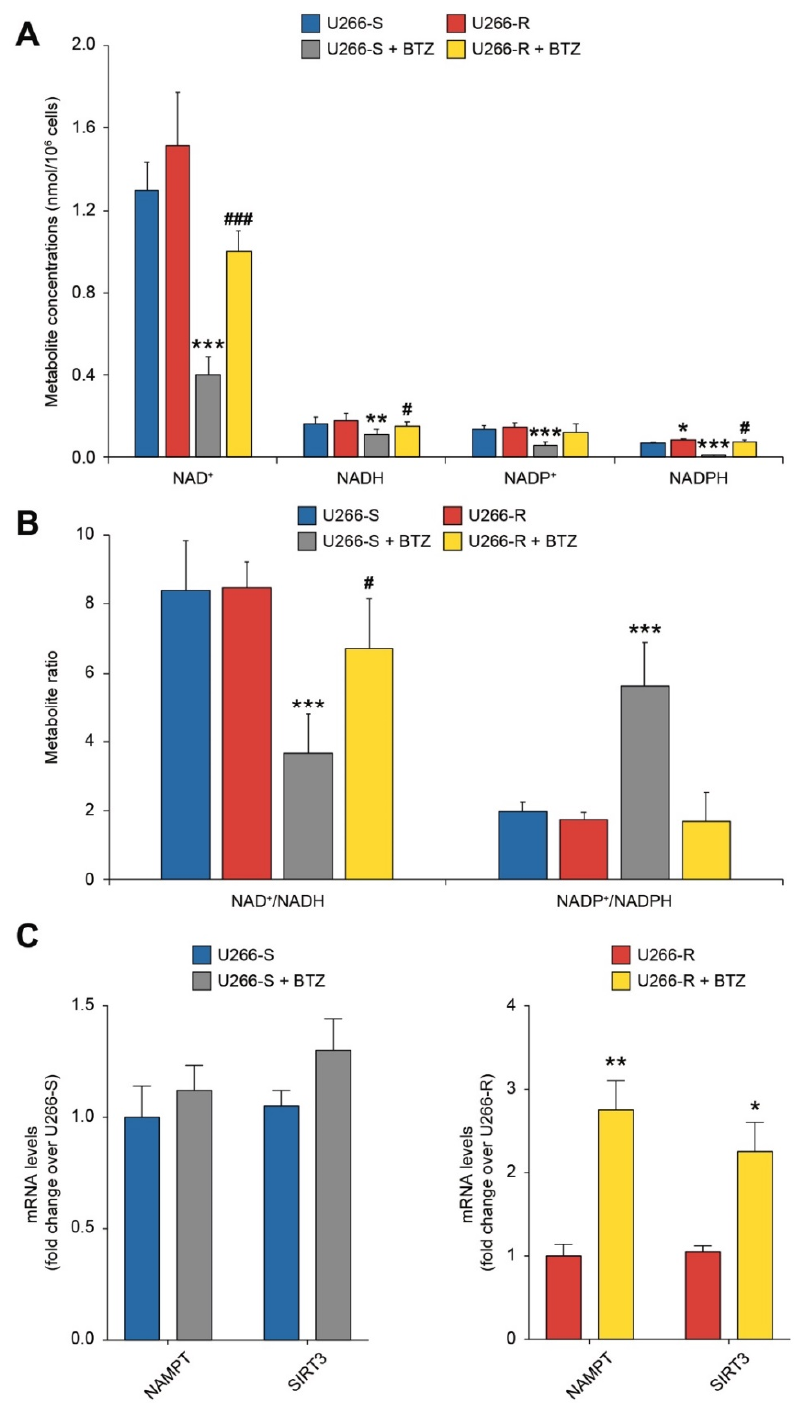
Figure 6. Redox state of nicotinic coenzymes in U266-S and U266-R after exposure to BTZ. ( A , B ) Metabolite concentrations expressed as nmol per 10 6 cells ( A ) and NAD + /NADH and NADP + /NADPH ratios ( B ) in U266-S and U266-S + BTZ and in U266-R and U266-R + BTZ. Data are shown as mean ± SEM of n = 4 biological replicates; * p -value < 0.05 and *** p -value < 0.001 versus U266-S; # p -value < 0.05 and ### p -value < 0.001 versus U266-S + BTZ. ( C ) mRNA levels of NAMPT and SIRT3 in untreated U266-S, U266-S + BTZ, U266-R and U266-R + BTZ cell lines; data are fold changes over untreated U266-S or U266-R and expressed as mean ± SEM of n ≥ 3 biological replicates; * p -value < 0.05 and ** p -value < 0.01 versus U266-R.